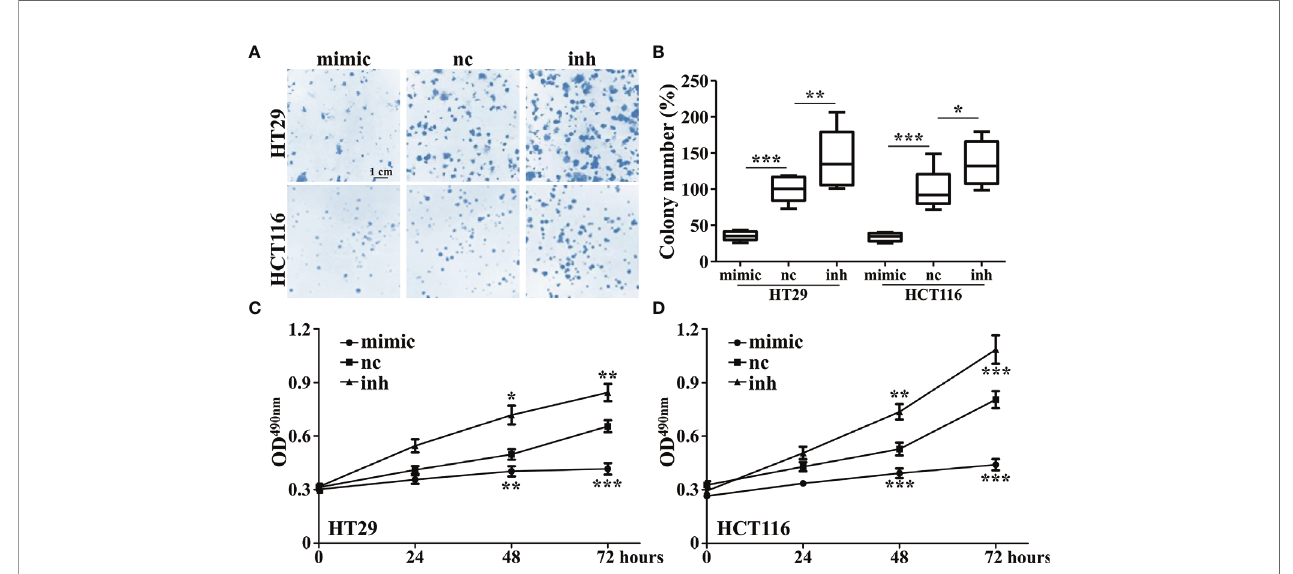
FIGURE 3 | Overexpression of miR-142-3p inhibits cell proliferation and colony formation of HT29 and HCT116 cells. (A) Colon formation in colorectal cancer cell lines (HT29 and HCT116) after overexpression of miR-142. Scale bar, 1 cm. (B) Summary and statistics of (A) . (C) MTT assay was conducted on HT29 cells. (D) MTT assay was conducted on HCT116 cells. All data are shown as means ± SD. *, ** and *** represent signi fi cant difference as p < 0.05, 0.01, and 0.001, respectively.